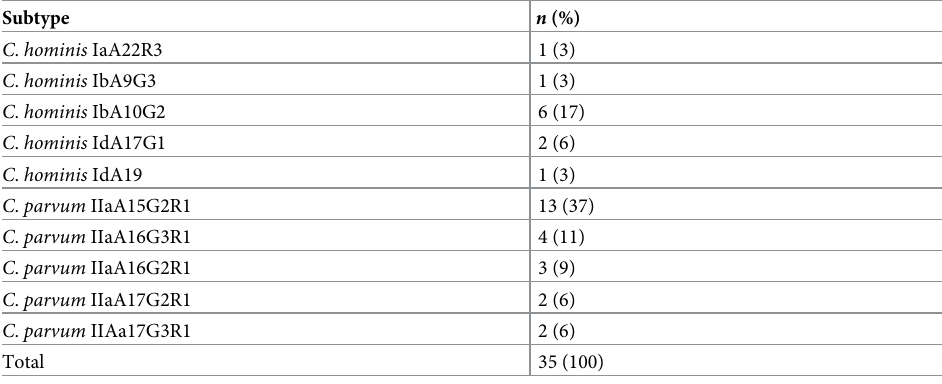
Table 3. Number and percentage of confirmed reported cases by Cryptosporidium subtype in Que´bec, Canada, 2016–2017.